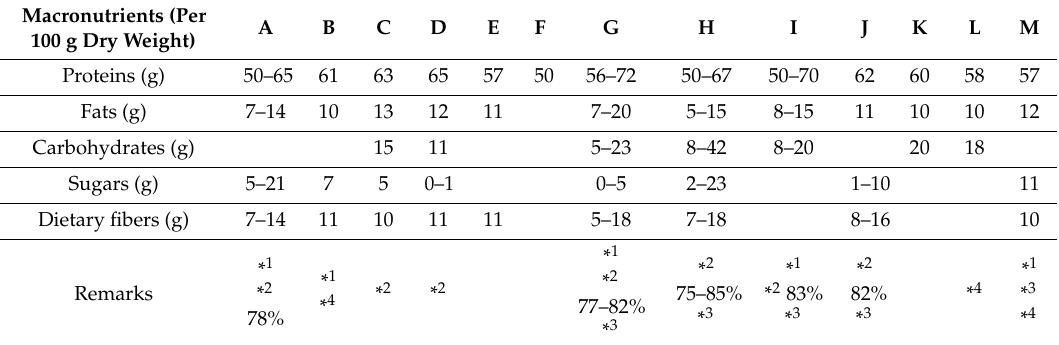
Table 1. Nutrient content of 13 commercially available Chlorella